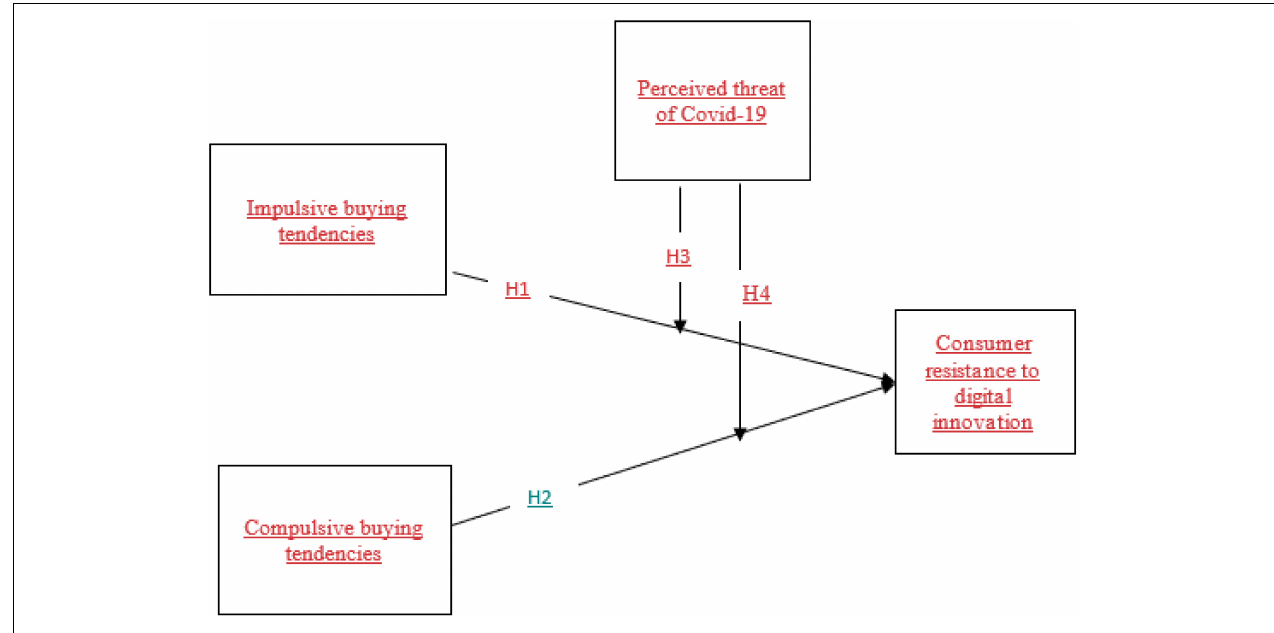
FIGURE 1 | Research